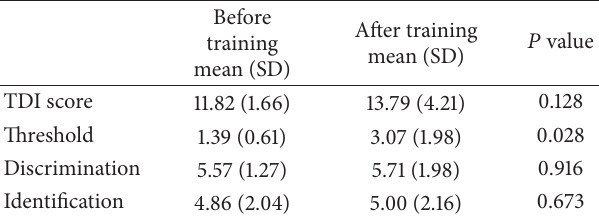
Table 1: Results of olfactory performance measurements before and after olfactory